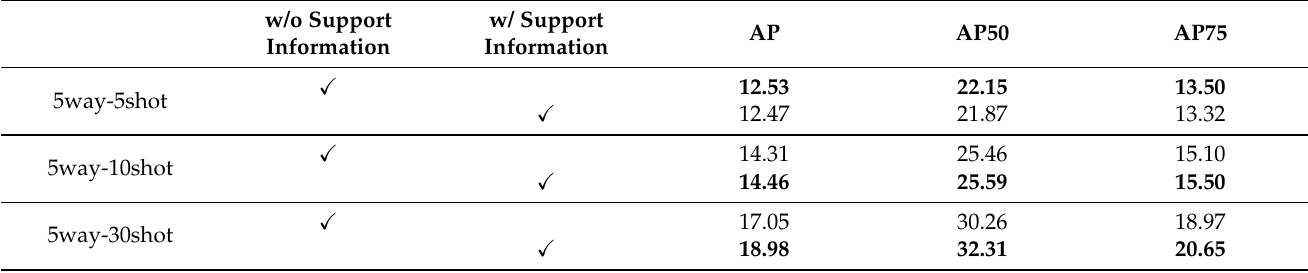
Table 7. The ablation result for using support information in Multi-Scale